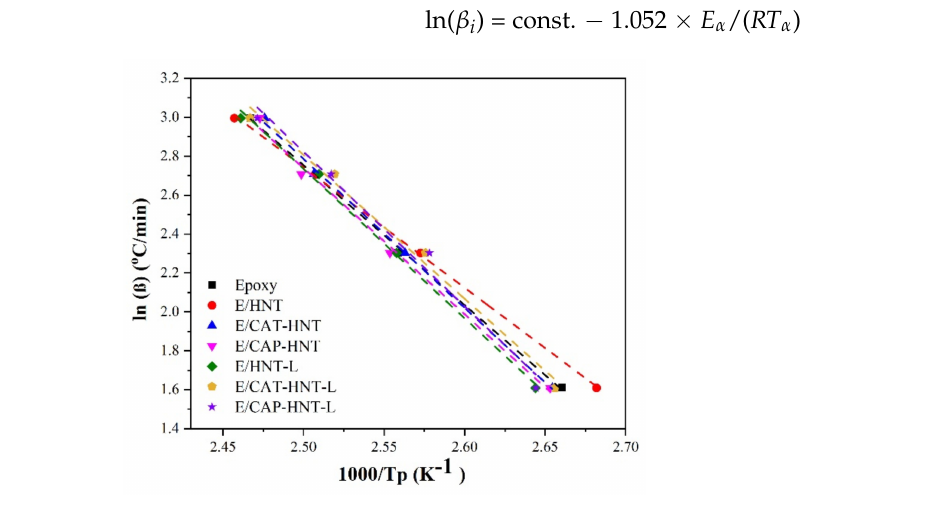
Figure A5. Plots of ln( β ) vs. 1/ T for epoxy resin and prepared nanocomposites derived from FWO